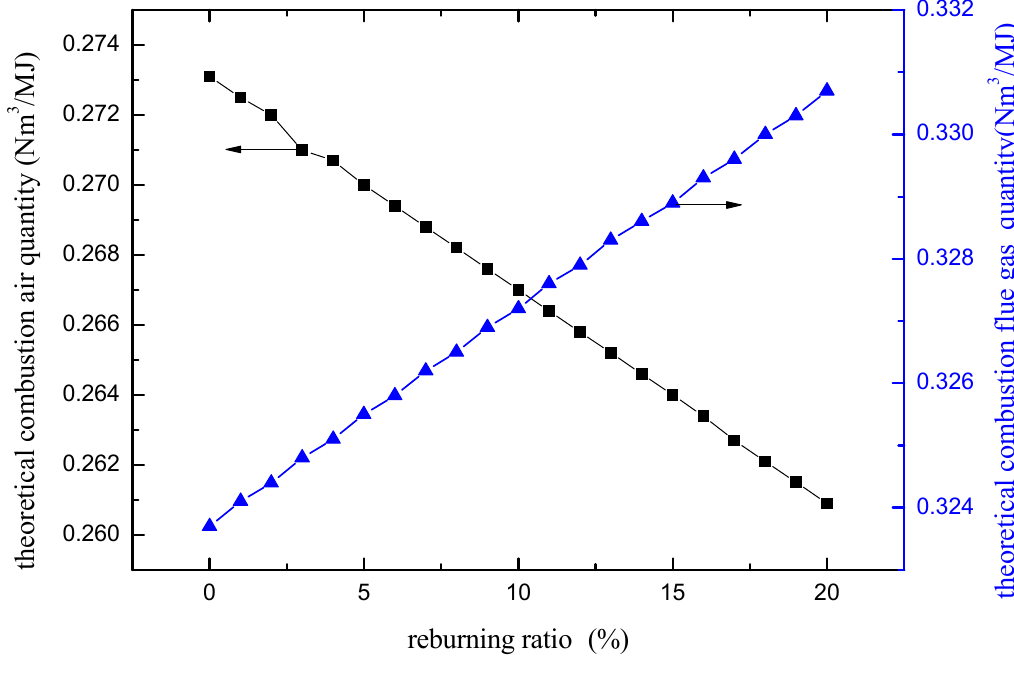
Figure 5. Influence of reburning ratio on theoretical air requirement and theoretical combustion flue gas